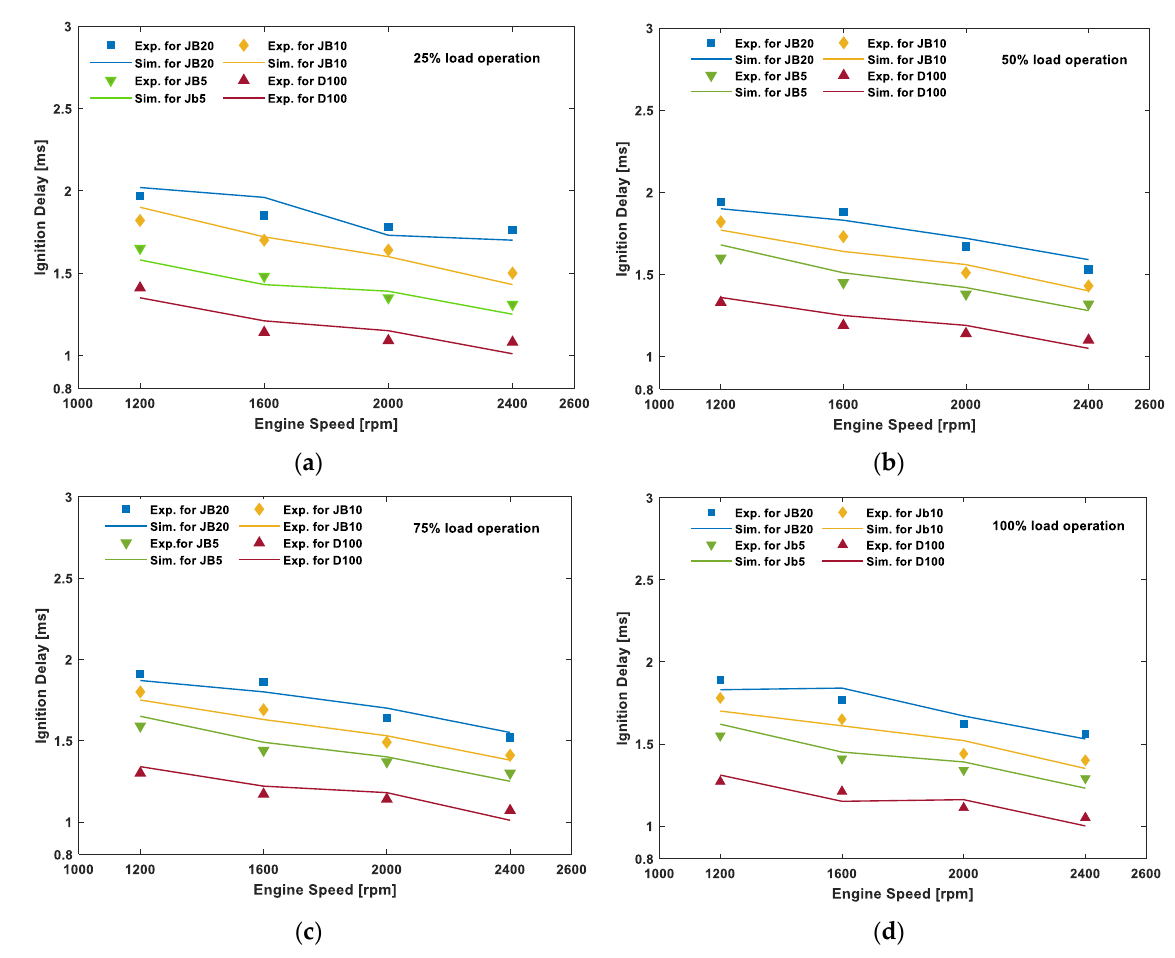
Figure 7. Comparison between simulation and experimental results of ID for diesel and JB blends at ( a ) 25%, ( b ) 50%, ( c ) 75% and ( d ) 100% loading conditions. ( a ) 25%, ( b ) 50%, ( c ) 75% and ( d ) 100% loading